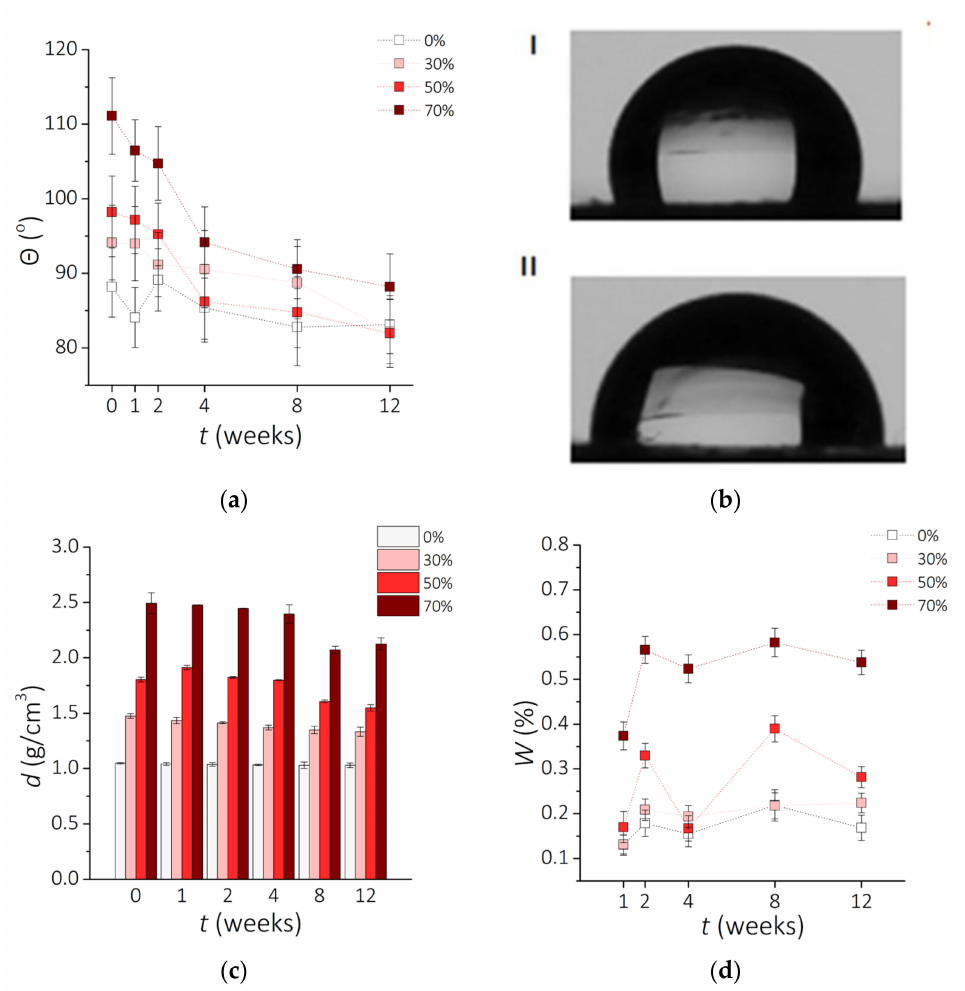
Figure 6. Physicochemical properties of the examined materials vs. incubation time t . ( a ) The change of the contact angle θ with the incubation time ( ± SD, n = 5). ( b ) Images of water droplets for two composites PDMS—70 wt.% MPs: before incubation 70-0 (I) and after 12 weeks of incubation 70-12 (II). ( c ) Changes of the density d of the composite with time of incubation ( ± SD, n = 5). ( d ) Water absorption W